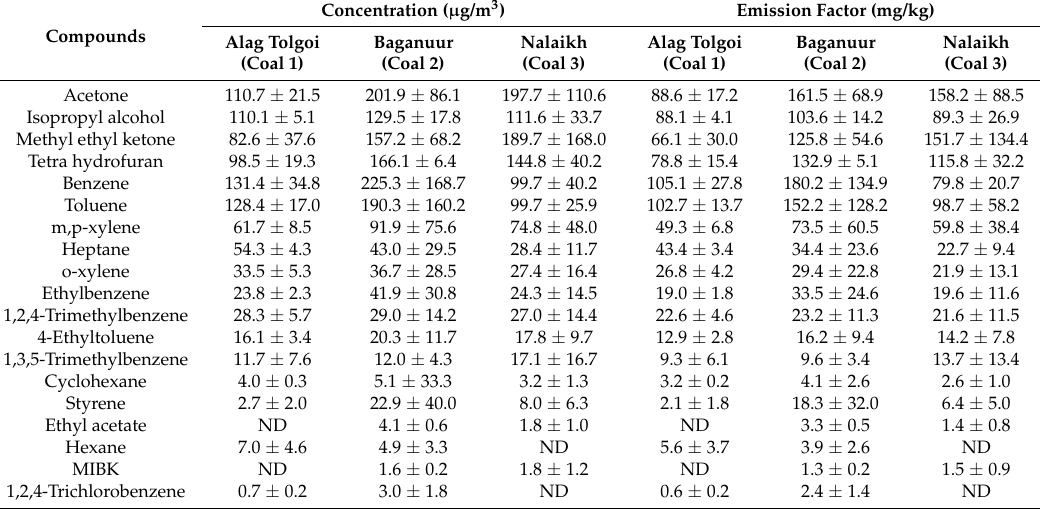
Table 4. Average concentration and emission factors of volatile organic compounds (VOCs) collected released during coal